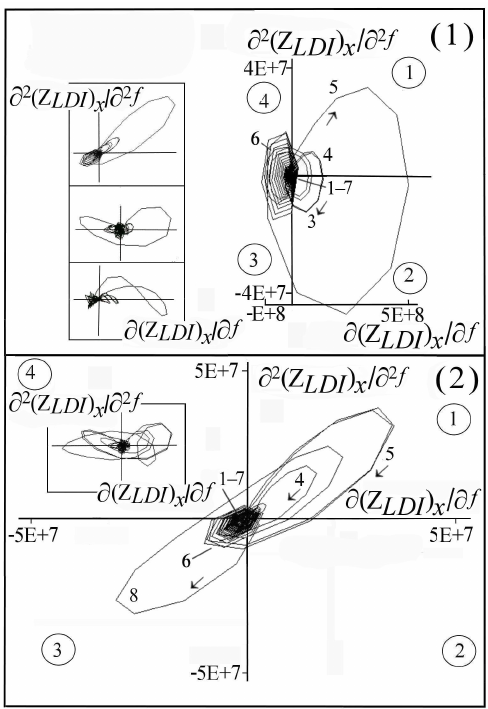
Figure 14. Phase-space derivative for diverging (events 3–5) and converging (event 8) loops in leaving funnel (event 6) in a region of peak A at a different viewing angle. Views ( 1 , 2 ).